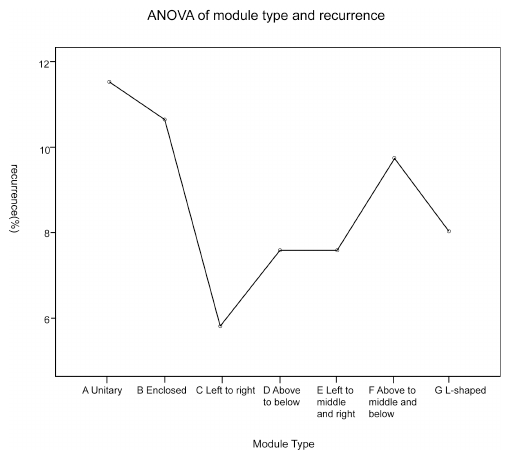
Figure 6. Sample with and without Cross-Stroke.